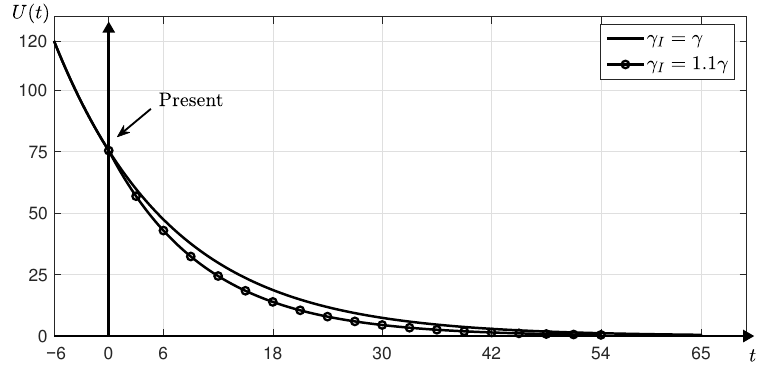
Figure 4. U ( t ) over time t until the epidemic is